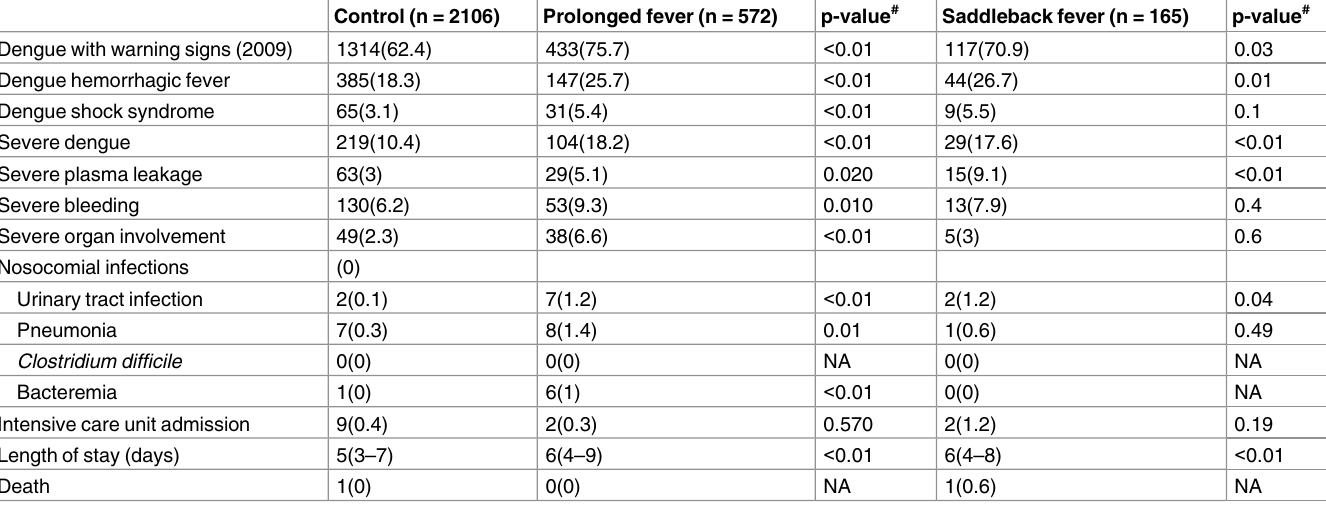
Table 3. Outcomes and complications occurring in hospitalized adult dengue